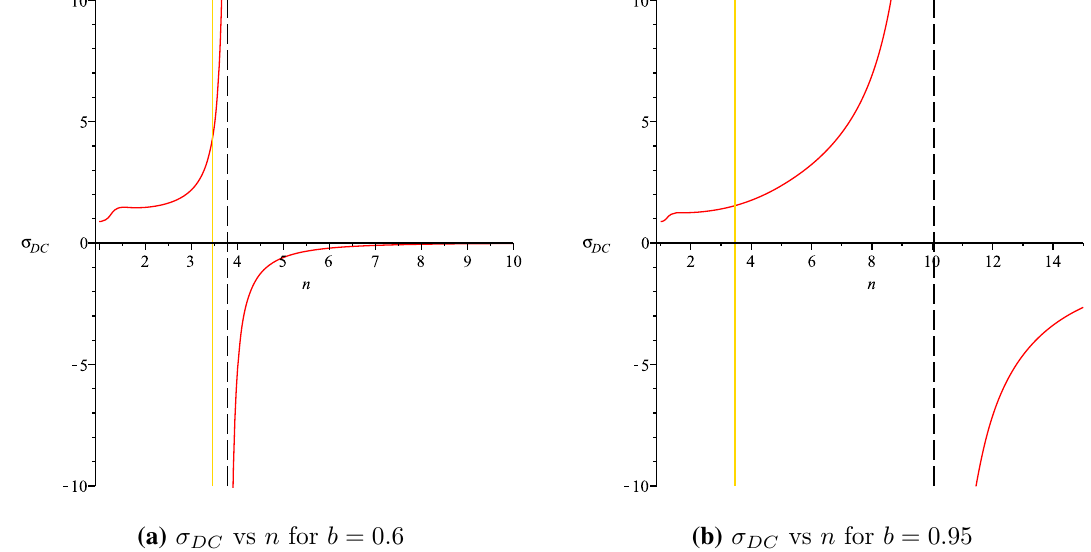
Fig. 3 Influence of the nonminimal coupling parameter n on the electric